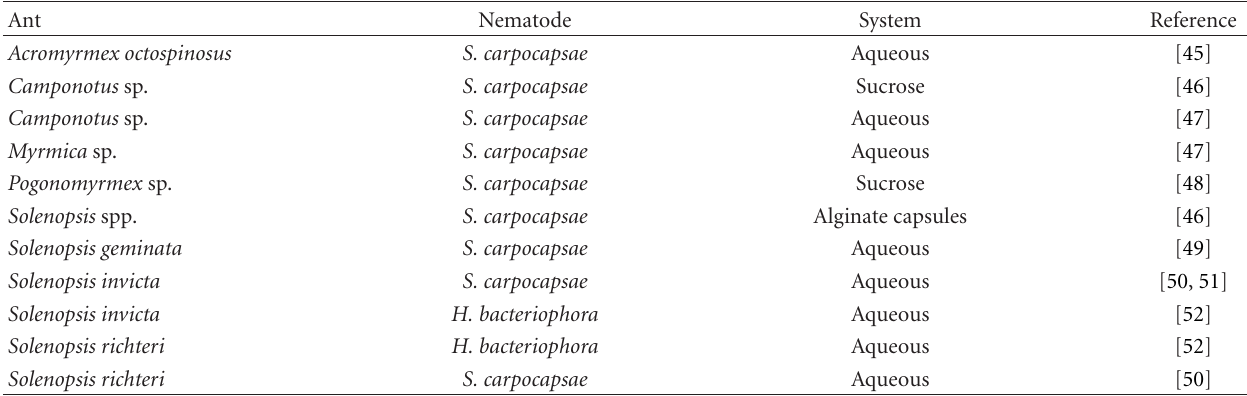
Table 4: Ants infected by entomopathogenic nematodes ( Steinernema carpocapsae and Heterorhabditis bacteriophora) under laboratory and/or field conditions.